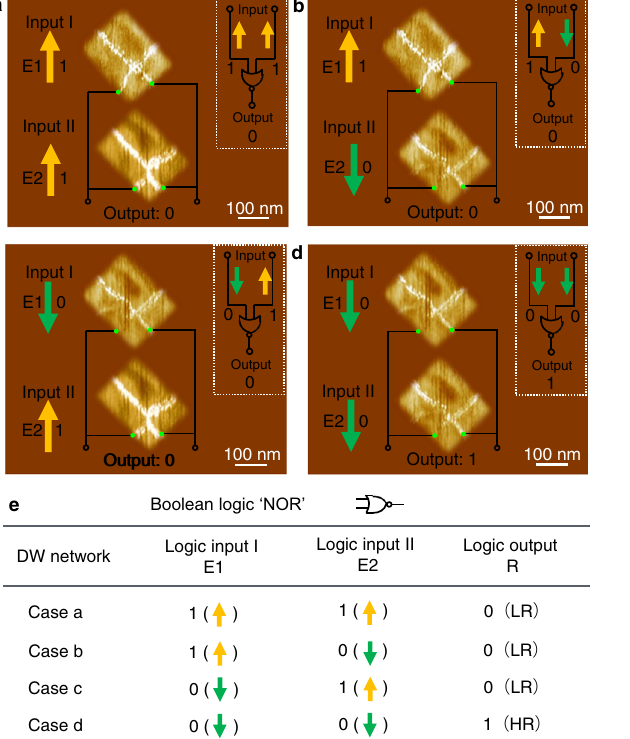
Fig. 4b, c, we design ‘ OR ’ and ‘ AND ’ logic gates by series- connected and parallel-connected two nano-islands with